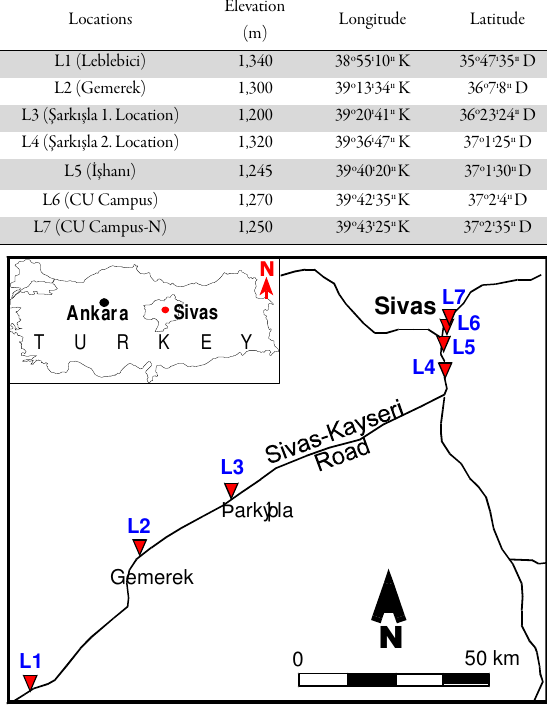
Fig. 1. Locations map